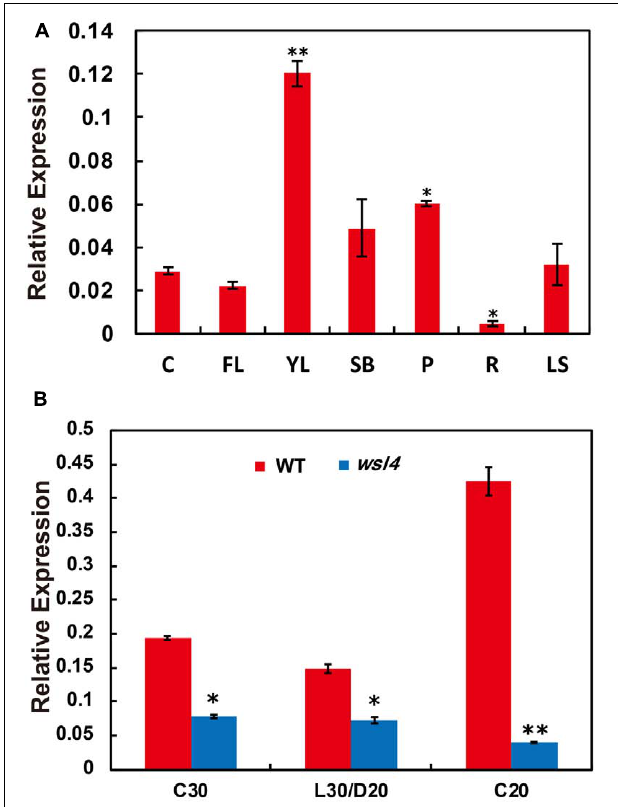
FIGURE 5 | Expression analyses of WSL4 , chloroplast-encoded, and nuclear-encoded genes as well as immunoblot analyses of plastidic proteins. (A) Relative expression of WSL4 in culms (C), flag leaf (FL), young panicles (P), and leaf sheaths (LS) from field-grown WT plants grown in the field at the booting stage, as well as young leaves (YL), shoot bases (SB), and young roots (R) from WT seedlings grown in a growth chamber at L30/D25. For t -test, values were compared with expression level of WSL4 in culms. Student’s t -test: ∗ P < 0.05; ∗∗ P < 0.01. (B) qRT-PCR analyses of WSL4 transcript in L3-3 from WT and wsl4 mutant seedlings grown in a growth chamber with a 12 h photoperiod at C30, L30/D25, and C20. Values are means ± SD of three replicates. Student’s t -test: ∗ P < 0.05; ∗∗ P <